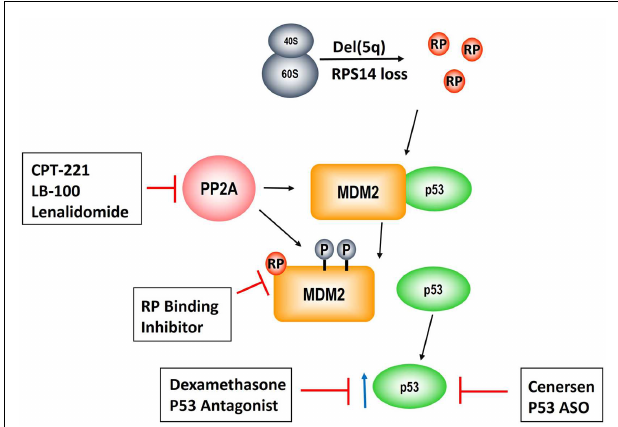
FIGURE 3 | Pathogenesis of the del(5q) MDS hematologic phenotype and novel therapeutic strategies to rescue erythropoiesis . Allelic deletion of the genes encoded in the del(5q) CDR disrupts ribosomal integrity via haploinsufficiency of RPS14 leading to RP, e.g., RPL11, sequestration of MDM2 and consequent p53 activation. PP2A is a negative regulatory phosphatase of MDM2 whose inhibition results in hyperphosphorylation at phosphate residues that protect it from ubiquitination. Lenalidomide abrogates the anemia in del(5q) MDS through PP2A inhibition. CP2-221 is a deuterium-modified analog of S -lenalidomide enantiomer with greater potency than the parent compound. LB-100 is a novel direct PP2A inhibitor that has entered clinical testing. Lastly, p53 modulation via dexamethasone and/or cenersen (p53 antisense) are exciting potential clinical strategies that are currently under clinical